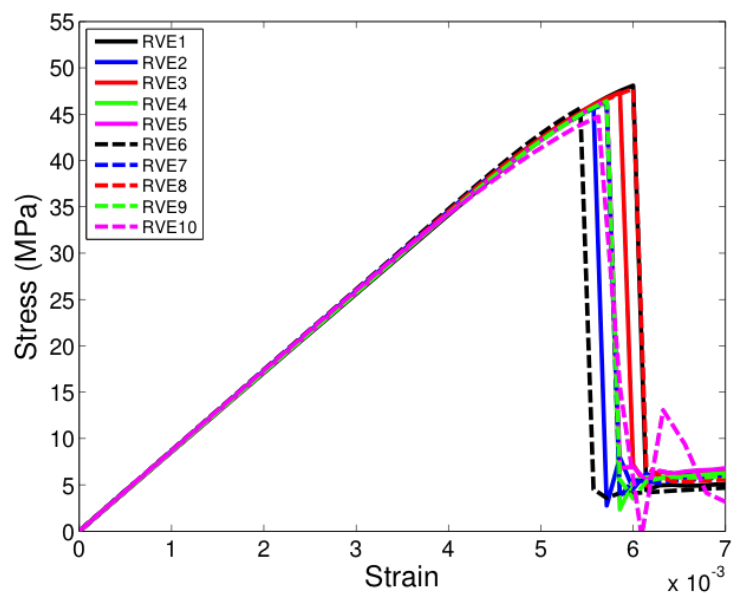
Figure 11. Transverse tensile response of 40-fiber unit cells with V